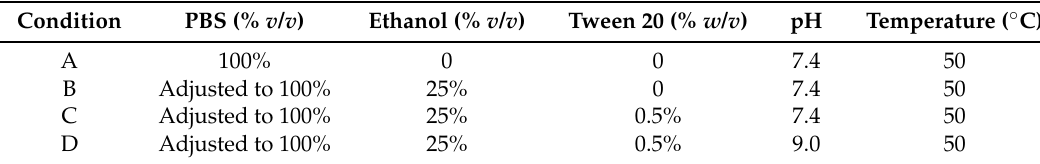
Table 2. Release testing conditions used for accelerated in vitro release method